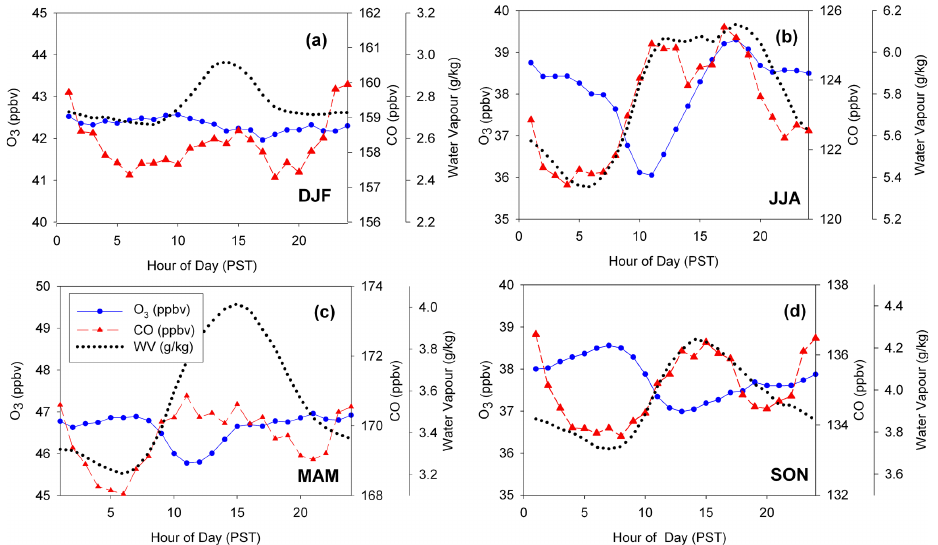
Fig. 2. Diurnal variation in ozone, CO, and water vapour at Whistler Peak 2002–2006 for (a) December–February, (b) June–August, (c) March–May, and (d) September–November. CO mixing ratios are averages of data smoothed with a three-hour running mean.